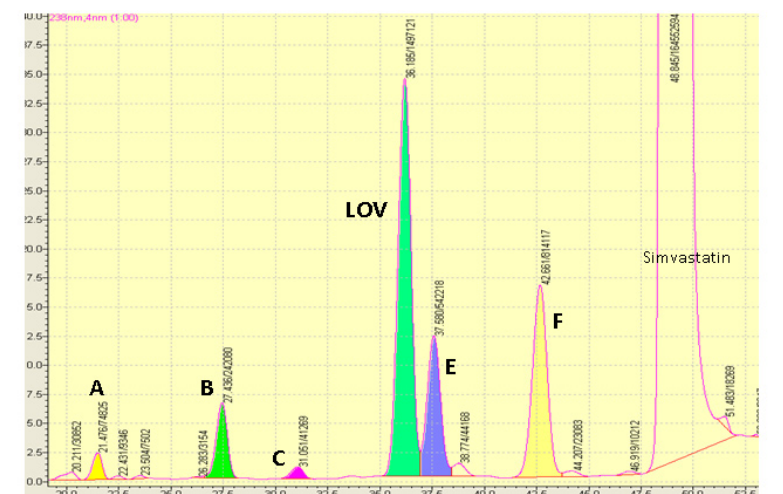
Figure 1. The part of chromatogram of Ximve 20 with marked of six impurity peaks: A, B, C, LOV, E, F and simvastatin.